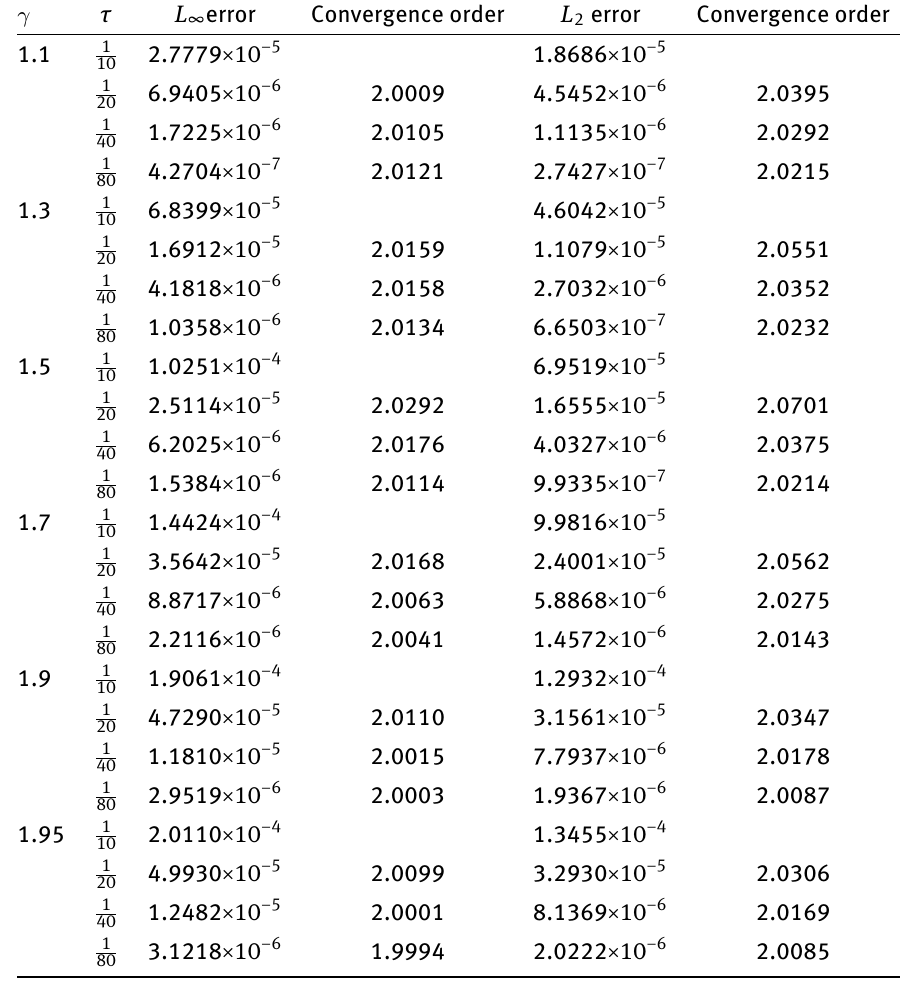
Table 3: The L ∞ , L 2 errors and temporal convergence orders with τ = h for Example 2.